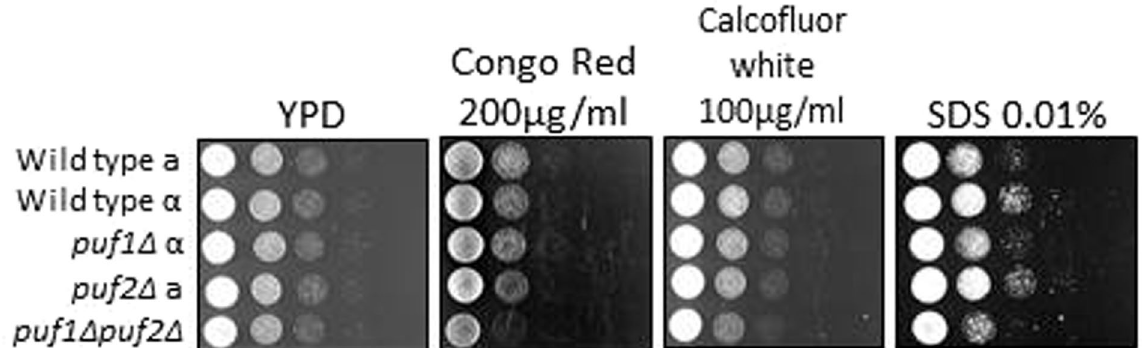
Figure 3. Effect of Puf1 and Puf2 deletions on growth under cell wall stress conditions. Wild-type mating type ‘a’ (WT ‘a’) (yA635), wild-type mating type α (WT α )(yA995), puf1 Δ (yA1382), puf2 Δ (yA637) and puf1 Δ puf2 Δ (yA639) strains were grown in YPD and plated on YPD agar with the indicated cell wall stressors in 10-fold serial dilutions. Plates were incubated at 30 °C for one day (YPD, Congo red, Calcofluor white) or three days